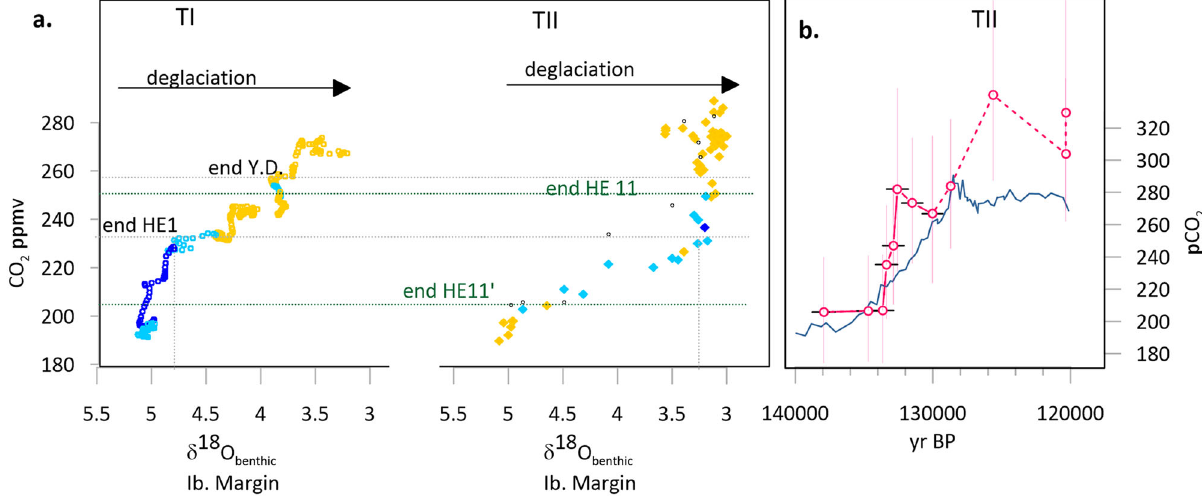
Fig. 8 Evolution of atmospheric pCO 2 during TI and TII. a The evolution of ice core pCO 2 for TI 64 and TII 7 versus benthic δ 18 O on the Iberian margin; benthic δ 18 O tuned to speleothem chronology for TII. Symbols are colored according to the C 37:4 alkenone abundance in the S. Iberian margin 58 (dark blue C37:4 > 6%; light blue C37:4 2 – 6%; yellow <2%) as an indicator of timing and intensity of HE climate impact. Horizontal gray lines emphasize CO 2 levels reached following abrupt rises during stadials in TI (HE1 and Y.D.), and horizontal dark green lines highlight CO 2 levels attained at the end of stadials in TII (HE11 ’ and HE11). b Comparison of the TII temporal evolution of CO 2 on ice core chronology (gray curve) 7 with pCO 2 estimated from marine proxies (pink, vertical bars show 95% CI on CO 2 estimate) 66 on speleothem chronology as discussed in Methods (horizontal bars show + / − 750 year uncertainty on age). The TII marine proxy pCO 2 estimates from between 138 and 128 ka are shown with small black squares in a), with error bars omitted for